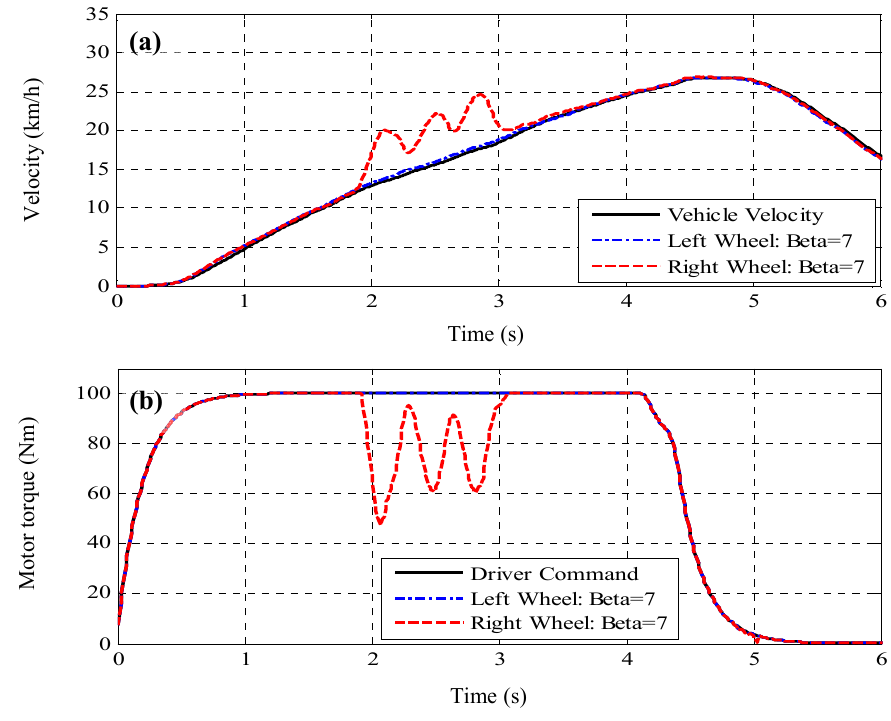
Figure 15. Experimental results with control (for 7   ): ( a ) Wheel velocity and estimated vehicle velocity; ( b ) Motor